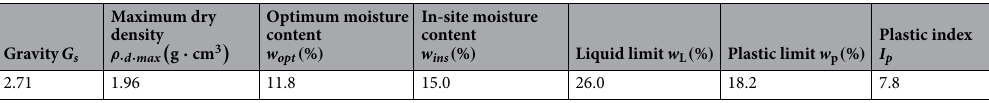
Table 1. Basic physical and mechanical properties of fine-grained soil.